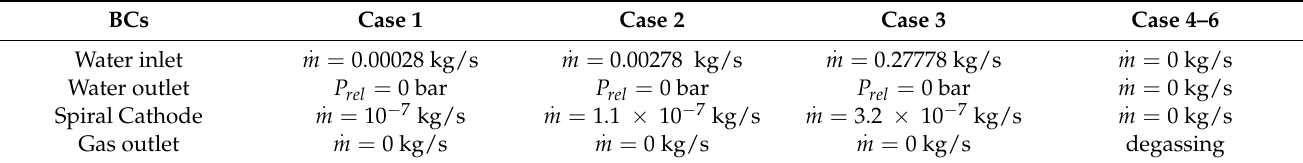
Table 3. Boundary conditions for Case 1–6 with the water inlet, water outlet, spiral cathode, and gas outlet. BCs